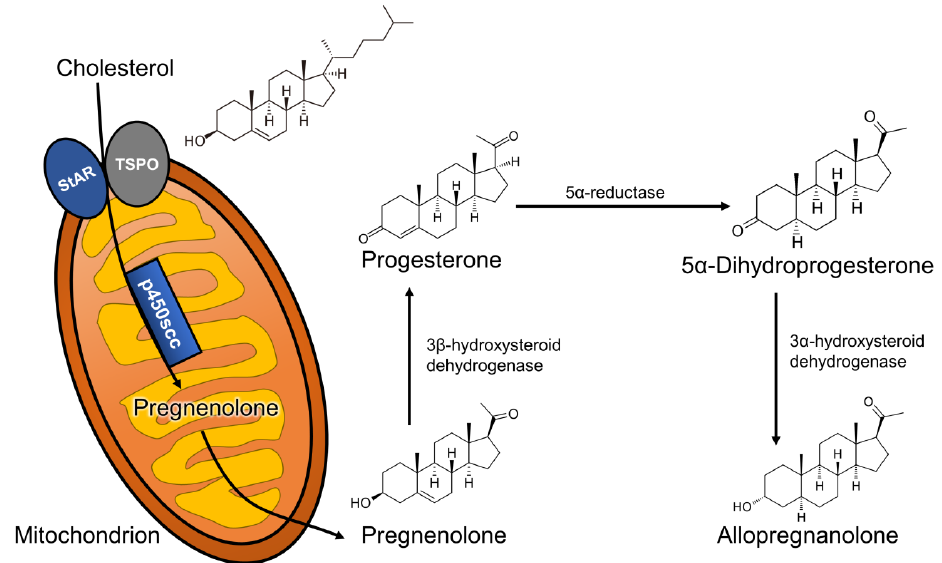
Figure 1. Allopregnanolone biosynthetic pathway starting from cholesterol metabolism. Abbreviations: StAR: steroidogenic acute regulatory protein; TSPO: 18 kDa translocator protein; scc: side-chain cleavage.